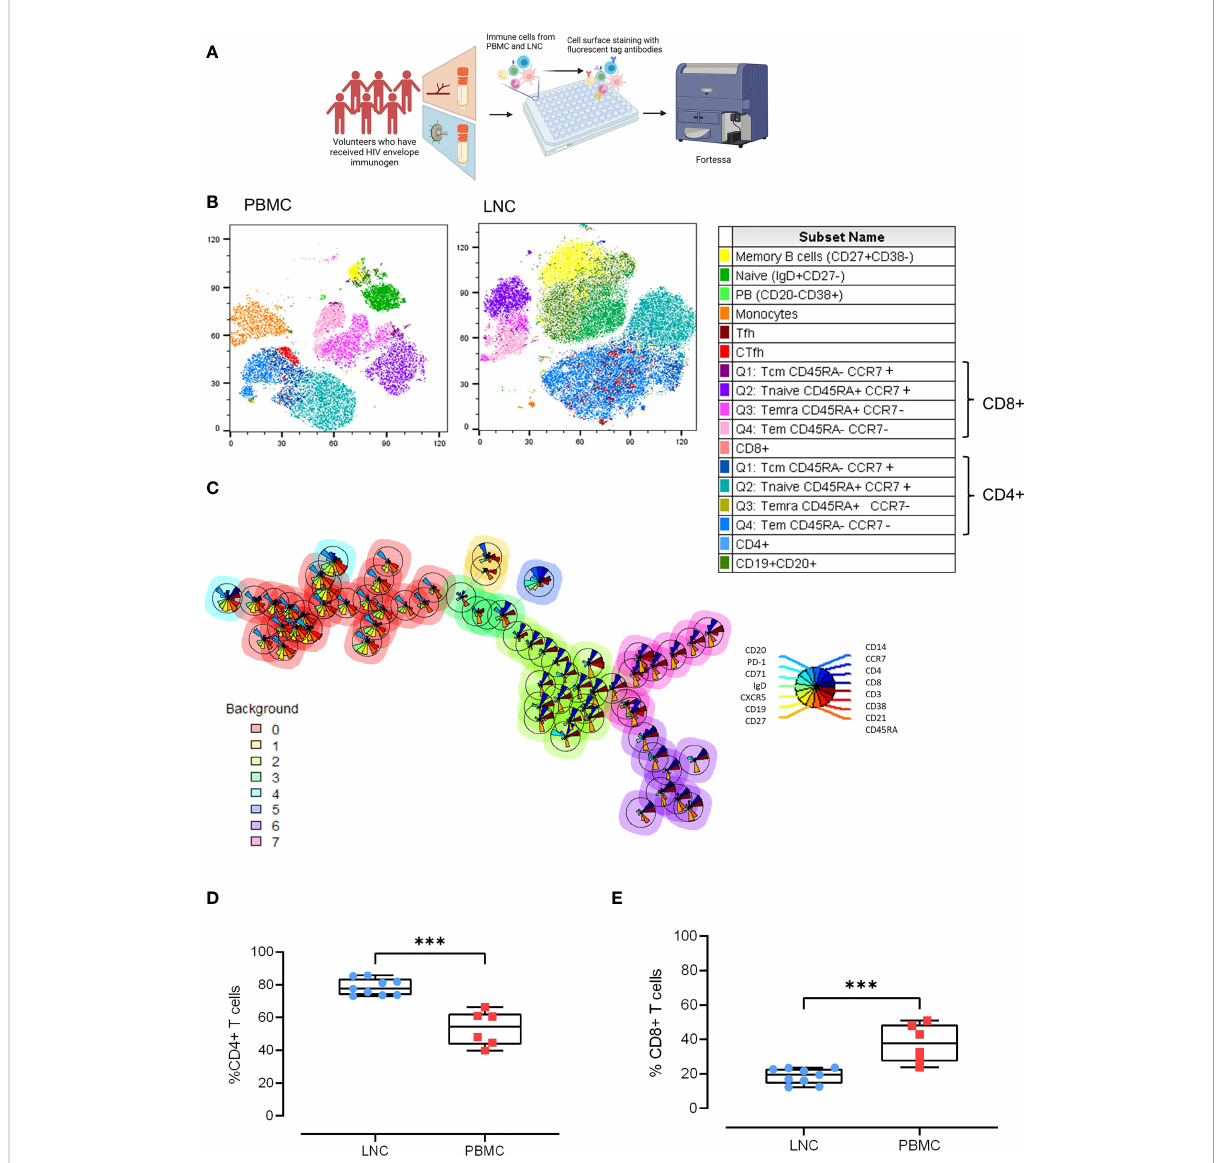
FIGURE 2 Comparison of the cellular landscape in blood and lymph node. (A) Paired PBMC and LNC from six participants were stained with a cocktail of 15 cell surface phenotyping markers and events acquired on a BD Fortessa fl ow cytometer. (B) t-distributed Stochastic Neighbor Embedding (t-SNE) representation of peripheral blood mononuclear cells (left panel) and lymph node cells (middle panel). The data were manually cleaned (gated on FlowJo on time> Lymphocytes> FCS singlets> SSC> Singlets> Viability) and concatenated on the down sample of each participant ’ s live population- 10,000 events. Seventeen cell subsets were de fi ned by manual cell gating and are displayed on the plots by color distribution as shown in the legend (right panel). 1. Memory B cells: CD19+ CD20+ CD27+ CD38-; 2. Naïve B cells: CD19+ CD20+ IgD+ CD27-; 3. Plasmablasts: CD19+CD20-CD38+; 4. Monocytes: CD14+CD19-; 5. T follicular helper cells (Tfh):CD4+CD19-CD45RA-CXCR5+PD-1+; 6. Circulating T follicular helper cells (cTfh): CD4+CD19-CD45RA-CXCR5+; 7. CD8+T central memory cells (Tcm) CD45RA+ CCR7+; 8. CD8 +Tnaive cells CD45RA+CCR7+; 9. CD8+Temra cells CD45RA+ CCR7-; 10. CD8+T effector memory cells (Tem) CD45RA- CCR7-; 11. CD8+ T cells; 12. CD4+T central memory cells (Tcm): CD45RA- CCR7+; 13. CD4+Tnaive cells: CD45RA+CCR7+; 14. CD4+Temra cells: CD45RA+ CCR7-; 15. CD4+T effector memory cells: (Tem) CD45RA- CCR7-; 16. CD4+ T cells; 17. B cells CD19+CD20+. (C) Self-organizing maps (SOM) of the data represented in minimal spanning trees meta-clustered using FlowSOM from concatenated data from LNC from n=6 participants. The background color of each node represents one of eight metaclusters from 0 to 7 (legend left). The individual star charts for each node show the median intensities of each phenotypic marker (legend right). (D, E) Paired PBMC and LNC from n=6 participants ’ data were cleaned and gated according to the gating strategy. Each panel shows the individual data points for LNC (blue circles), PBMC (red squares) and the median and interquartile range as a box and whisker plot. Frequency of CD4+ T cells in live CD3+ T cells (D) , and frequency of CD8+ T cells in live CD3+ T cells (E) . The results of Mann-Whitney U tests are shown with